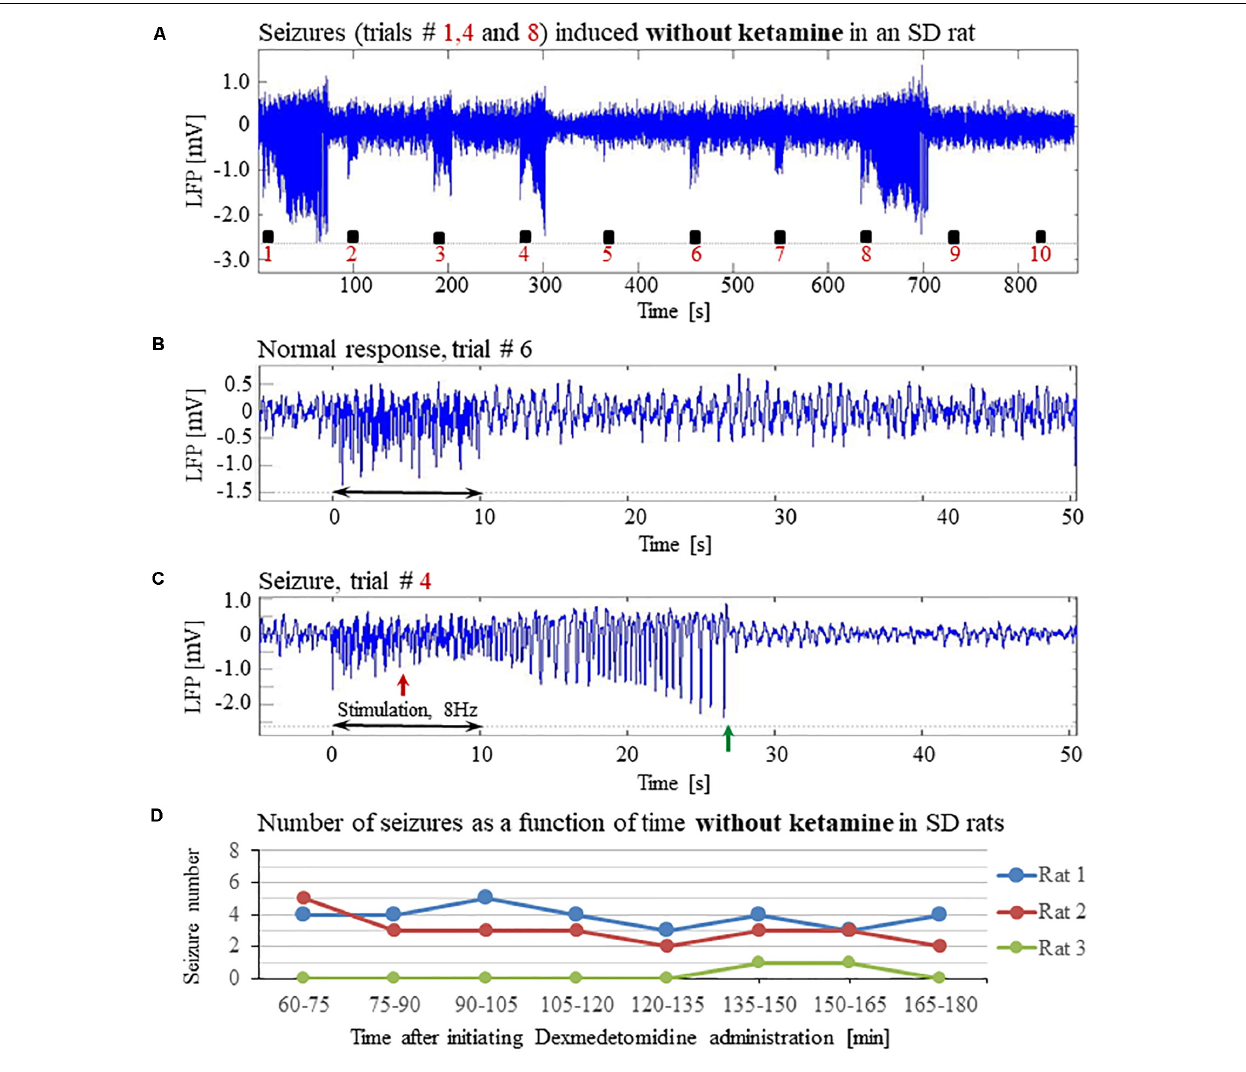
FIGURE 4 | The increased susceptibility to seizures in SD rats under dexmedetomidine and buprenorphine does not depend on ketamine. The data presented in this figure were obtained from 3 rats under dexmedetomidine and buprenorphine sedation with no administration of ketamine. The format of the presentation is similar to that used in Figure 1 . (A) A time-course of LFP (averaged over electrode contacts spanning the cortical depth) recorded during ten trials, each with 10 s-long stimulation. The stimulation periods are marked by black rectangles. Note the seizures induced by the stimulus in the first, fourth, and eighth trials. (B) A normal-evoked LFP response recorded in trial #6. (C) A seizure pattern recorded in trial #4. The red and green arrows indicate the onset and termination of the seizure, respectively. (D) The number of seizures recorded in each of the 3 rats as a function of time after the initiation of the dexmedetomidine